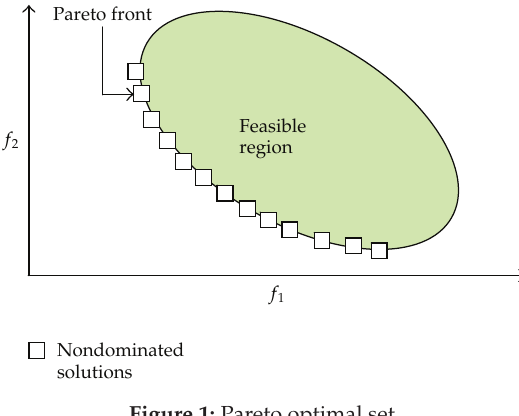
Figure 1: Pareto optimal